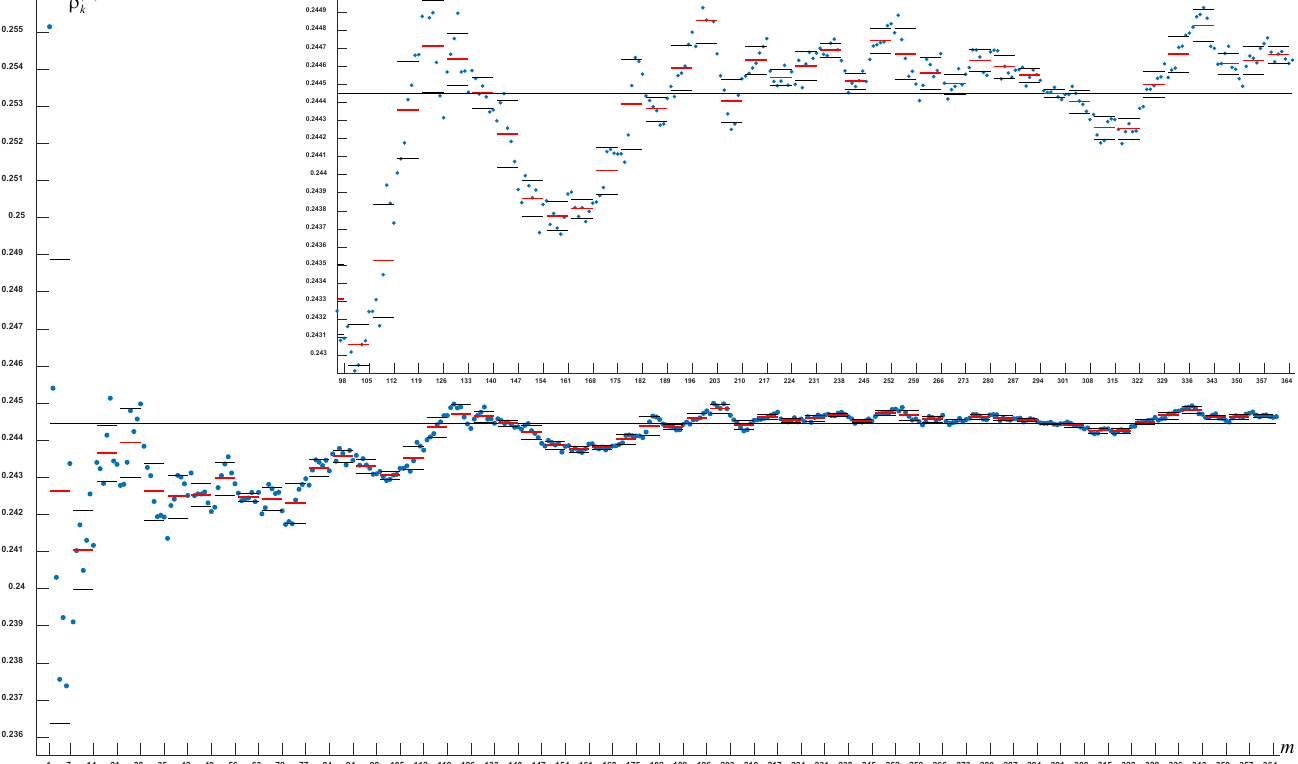
Fig. 3. Another example of approximations (11) obtained by generating wind speed registration counts. This model is far “deeper” compared to the previous